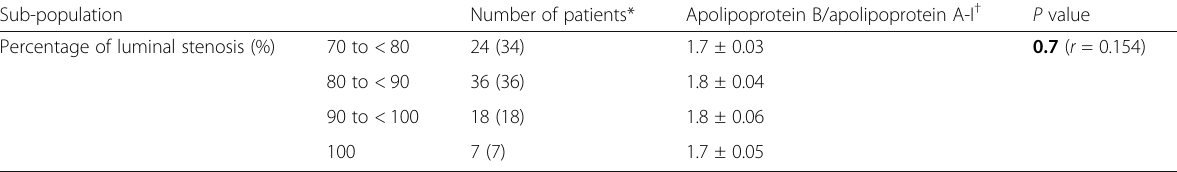
Table 4 Mean ApoB/ApoA-I ratio in relation to maximum coronary luminal stenosis in the NSTE-ACS group